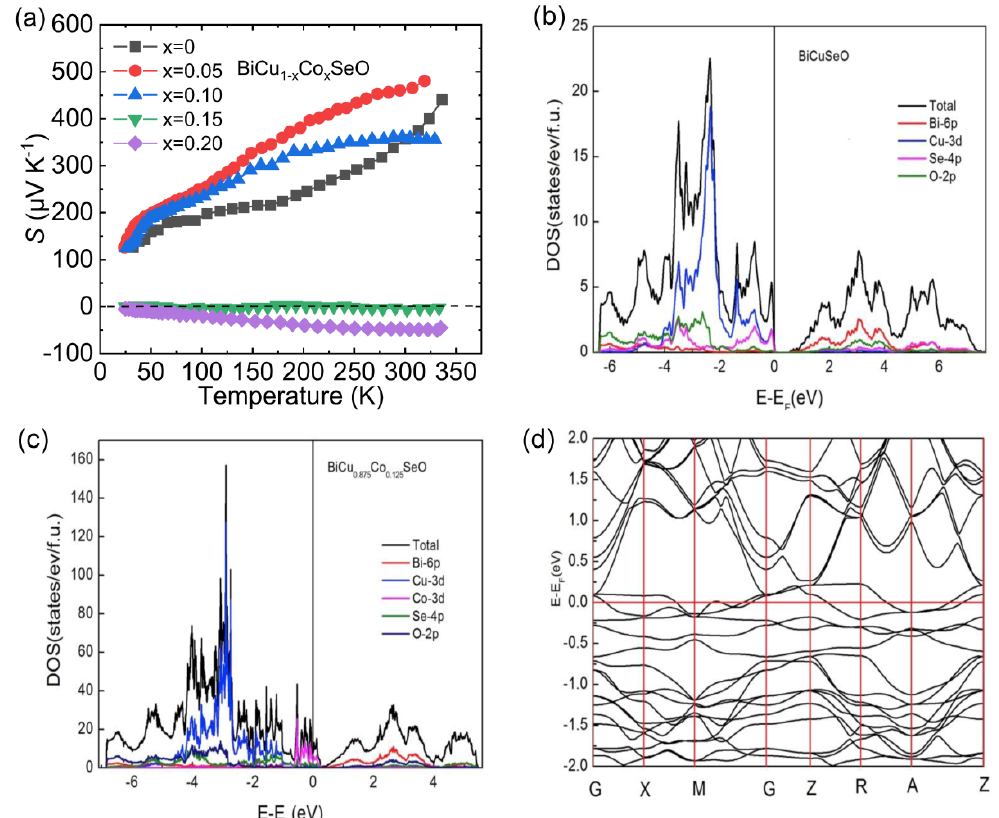
Figure 3. ( a ) The temperature-dependent Seebeck coefficient of BiCu 1-x Co x SeO ( x = 0.05–0.20). Data were adopted from Reference [55]. Copyright 2019, Elsevier Masson SAS. Calculated density of states (DOS) of ( b ) BiCuSeO and ( c ) BiCu 0 . 875 Co 0 . 125 SeO, and ( d ) electronic band structure of BiCu 0 . 875 Co 0 . 125 SeO. ( b – d ) Reproduced with permission from Reference [55]. Copyright 2019, Elsevier Masson SAS.